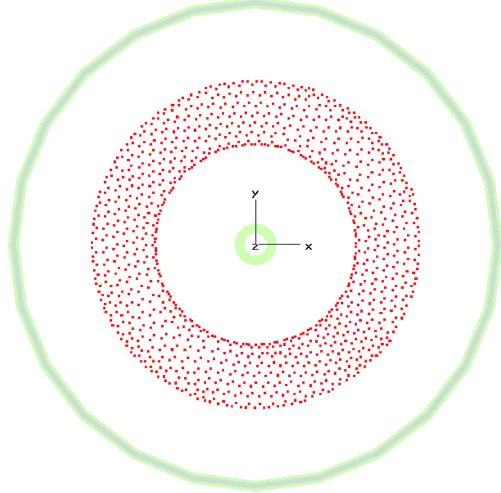
FIG. 19. (Color) The front view of drive bunch electrons after 13.2 psec of the travel (bunch head is located at 3.967 mm from the structure input). Different colors of simulated electrons indicate different energy losses. Dielectric tubes are shown in